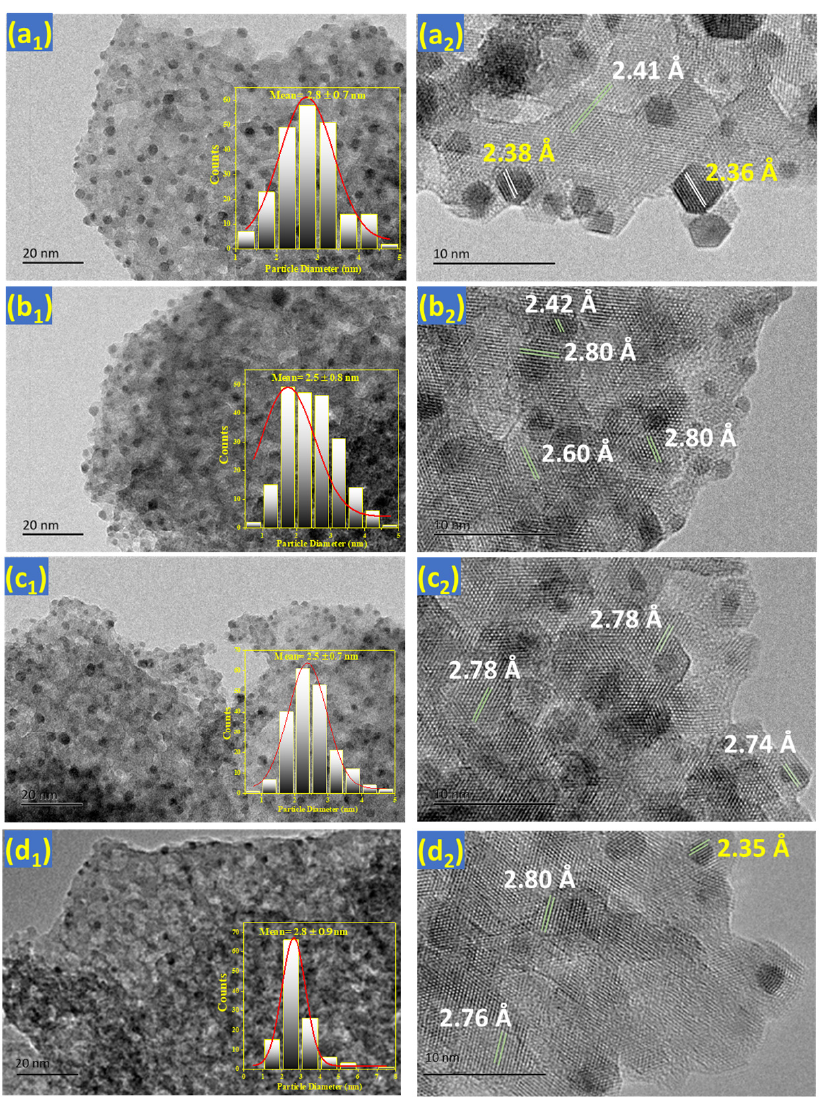
Figure 3. TEM (a 1 − d 1 ) and HRTEM (a 2 − d 2 ) images of supported gold catalysts: ( a 1 − 2 ) Au 25 /Zn 3 Al- Figure 3. TEM (a 1 –d 1 ) and HRTEM (a 2 –d 2 ) images of supported gold catalysts: ( a 1–2 ) Au 25 /Zn 3 Al-400; 400; ( b 1 − 2 ) Au 25 /Zn 2 Al-400; ( c 1 − 2 ) Au 25 /Zn 1 Al-400; ( d 1 − 2 ) Au/Zn 2 Al-400 (deposition–precipitation ( b 1–2 ) Au 25 /Zn 2 Al-400; ( c 1–2 ) Au 25 /Zn 1 Al-400; ( d 1–2 ) Au/Zn 2 Al-400 (deposition–precipitation (DP)).